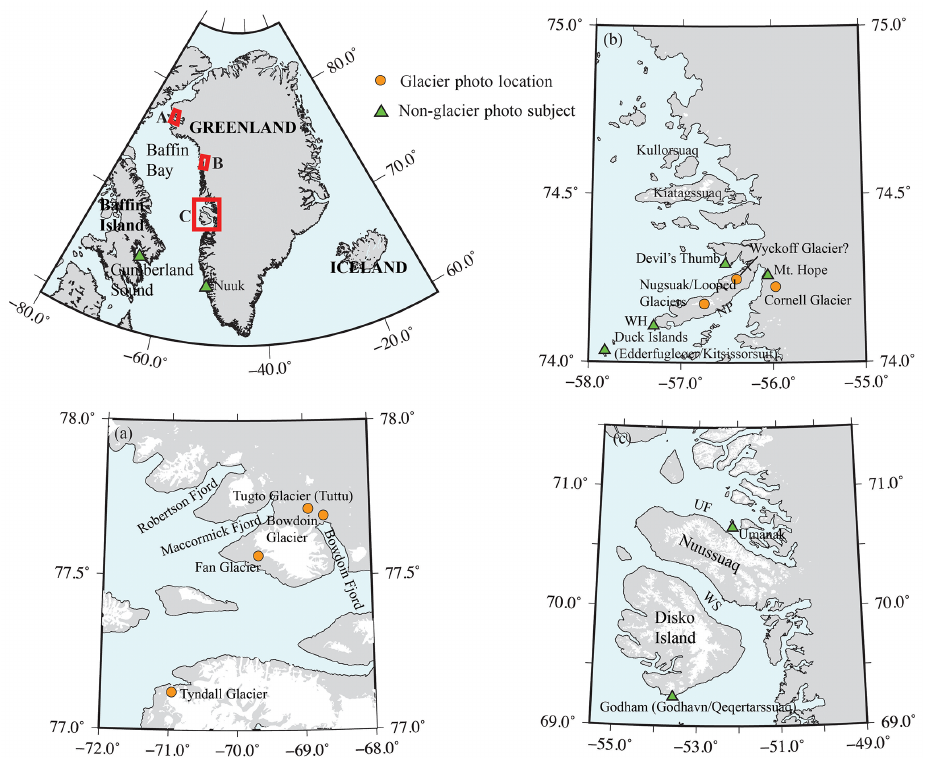
Figure 3. Sites visited in Greenland. (a) Site locations in the Qaanaaq region. (b) Site locations in the Upernavik Archipelago region. WH is Wilcox Head and NP is Nugsauk (Nuussuaq) Peninsula. (c) Site locations in the Disko Bay region. UF is Umenak (Umanak/Uummannaq) Fjord. WS is Waigat (Vaigat/Sullorsuaq)